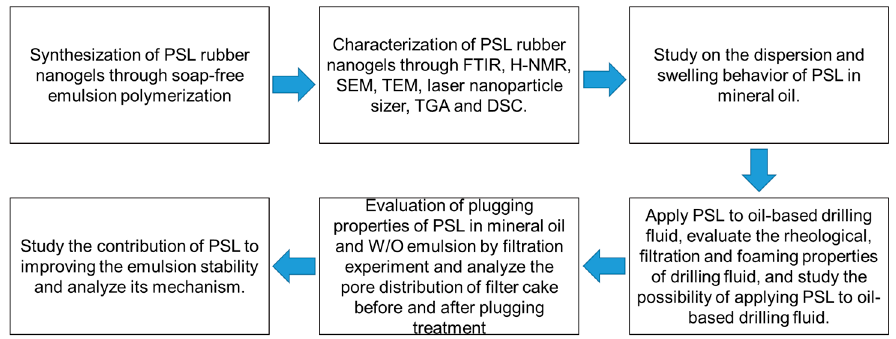
Figure 7. The workflow diagram of this research.